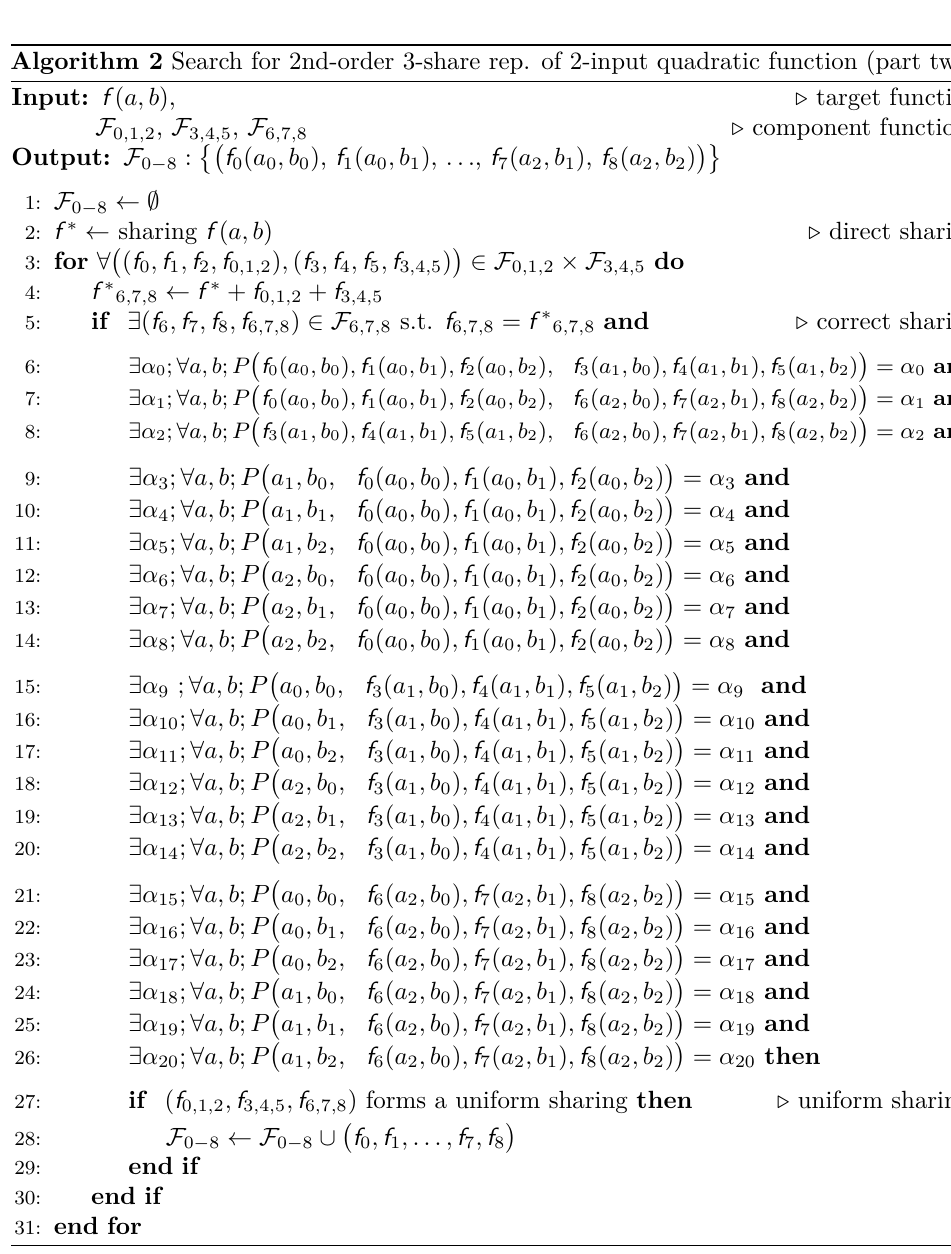
Algorithm 2 Search for 2nd-order 3-share rep. of 2-input quadratic function (part